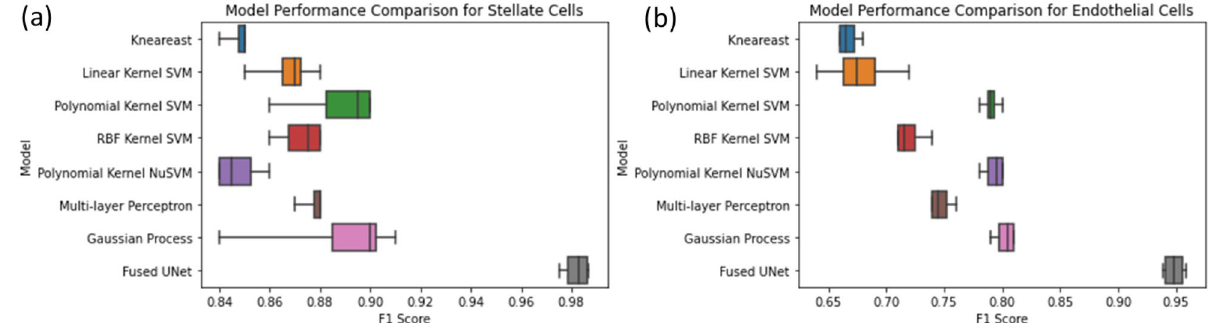
Figure 7. ( a ) Model performance comparison for HSC cells characterization; ( b ) model performance comparison for LEC cells